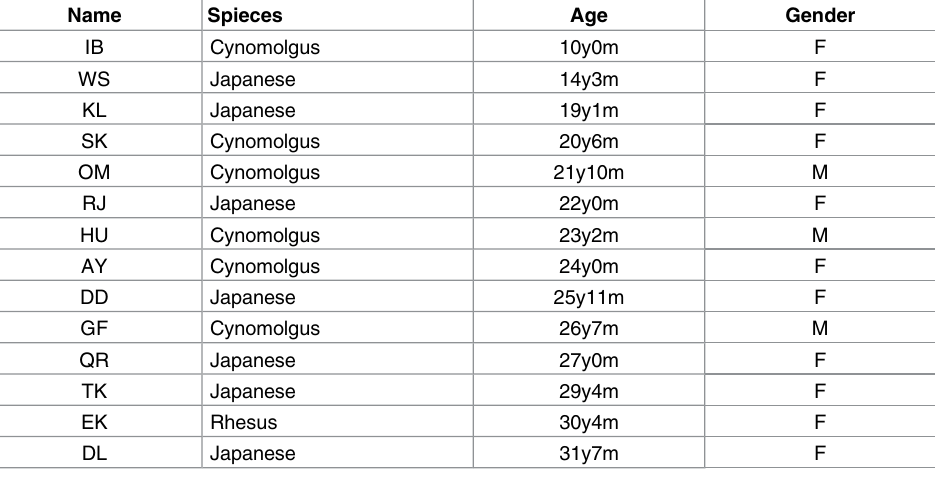
Table 1. List of macaquesused. Cynomolgus, cynomolgus monkey ( Macaca fascicularis ); F, female; Japa- nese, Japanesemonkey ( Macaca fuscata ); M, male; m, months; Rhesus, rhesus monkey ( Macaca mulatta ); y,